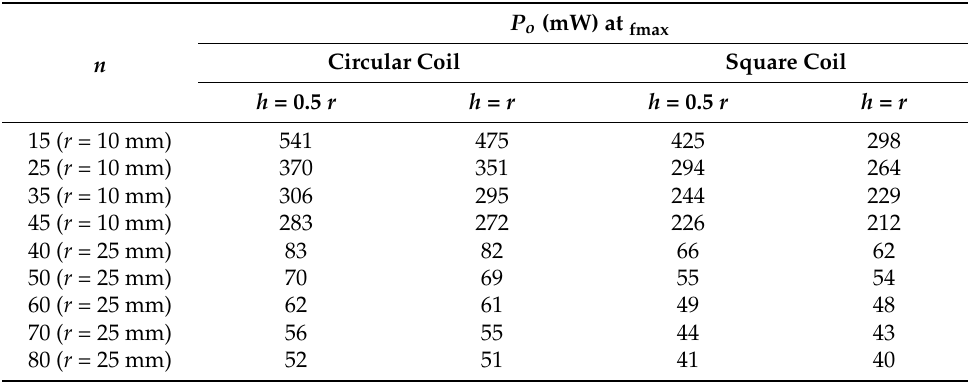
Figure 18. Load impedance at f max to obtain maximum load power for coil with r = 25 mm at distances: ( a ) h = 0.5 r ; ( b ) h = r . The maximum load power values depending on the type of the coils, the number of turns and the distance ( h ) are presented in Table 10. In each case, higher power transfer efficiency values were obtained for the circular coil than for the square one. The maximum load power at the receiver is about 20% greater for the circular coil than for the square one. Table 10. Maximum load power values at f max for all analyzed